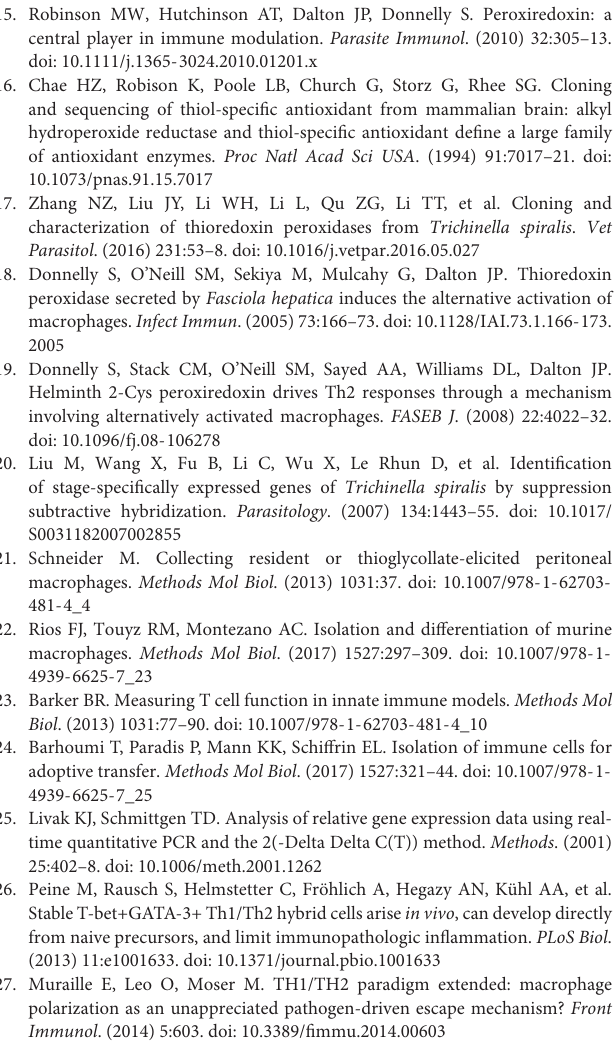
Supplementary Figure 4 | The phenotype of macrophages induced in vitro by flow cytometry. The expressions of MRC-1 (A) and iNOS-1 (B) . Genes were analyzed by flow cytometry; the left panel was determined by Flowjo software (TreeStar, Ashland, OR, United States), while the right panel shows the mean of fluorescence intensity experimental group. RAW264.7 macrophages were incubated with respective proteins for 48 h. The PBS was used as non-treated control; the recombined mouse Cyclic GMP-AMP synthase (rmcGAS) expressed in the same system with rTsTPX2 was used as irrelevant control; the recombined IL-4 as M2 positive control and IFN- γ as M1 positive control. The following fluorescence conjunct antibodies, Alexa Fluor R (cid:13) 647 rat anti-mouse CD206 (MRC-1), FITC mouse anti-iNOS-1, PE rat anti-mouse F4/80, and the Isotype control antibodies were purchased from BD Biosciences (United States). After staining, the macrophages were firstly gated with F4/80-positive cells, then the iNOS-1 and CD206 (MRC-1) positive cells analyzed with mean of fluorescence intensity